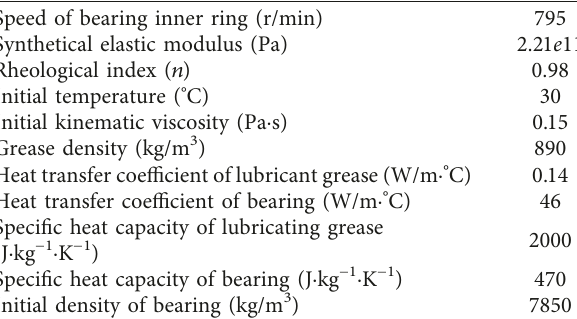
Table 2: Parameters of bearing lubricating grease.